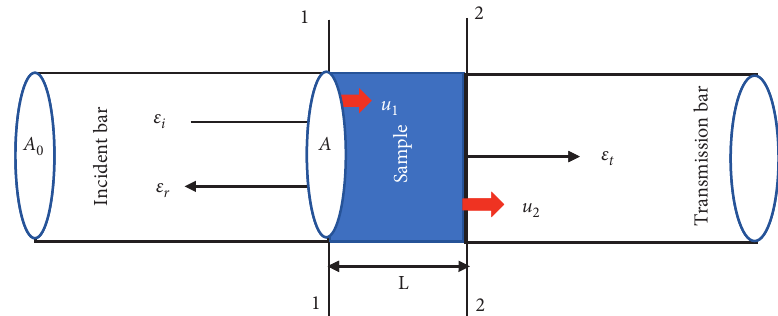
Figure 3: Schematic diagram of the rock sample under impact by SHPB.